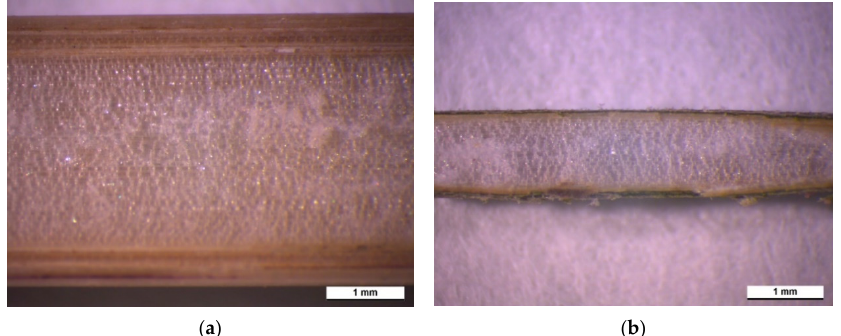
Figure 13. Structure of Miscanthus ( a ) and ( b ) lavender in a longitudinal cross-section.